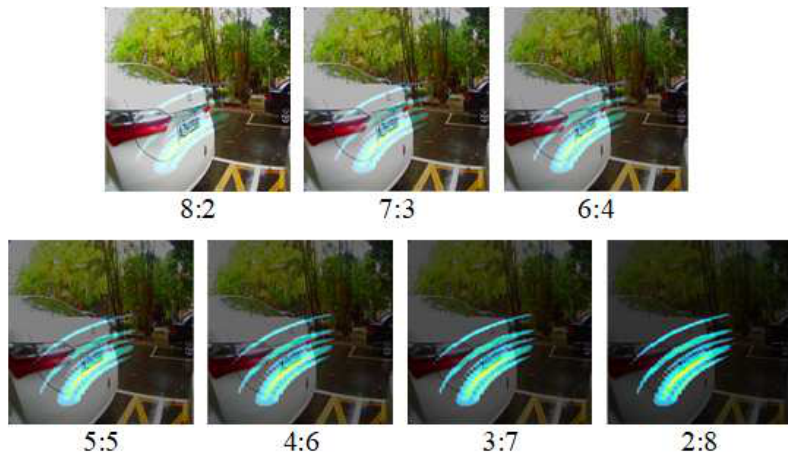
Figure 6. Heterogeneous image fusion with seven ratios.